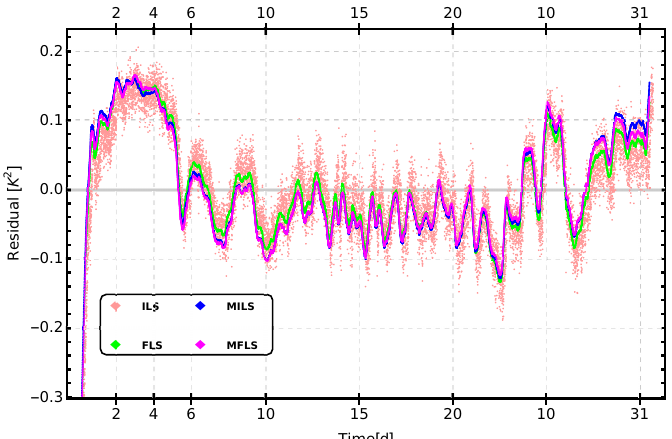
Figure 6. Residue plot, meaning the difference between measured and modeled temperatures for the 32-day test and model parameters estimated from the full 32-day dataset. Two of the plots (infinite moving line source (MILS) and moving finite line source (MFLS)) have been smoothed to highlight the average tendency, whilst the two others (infinite line source (ILS) and finite line source (FLS)) are directly